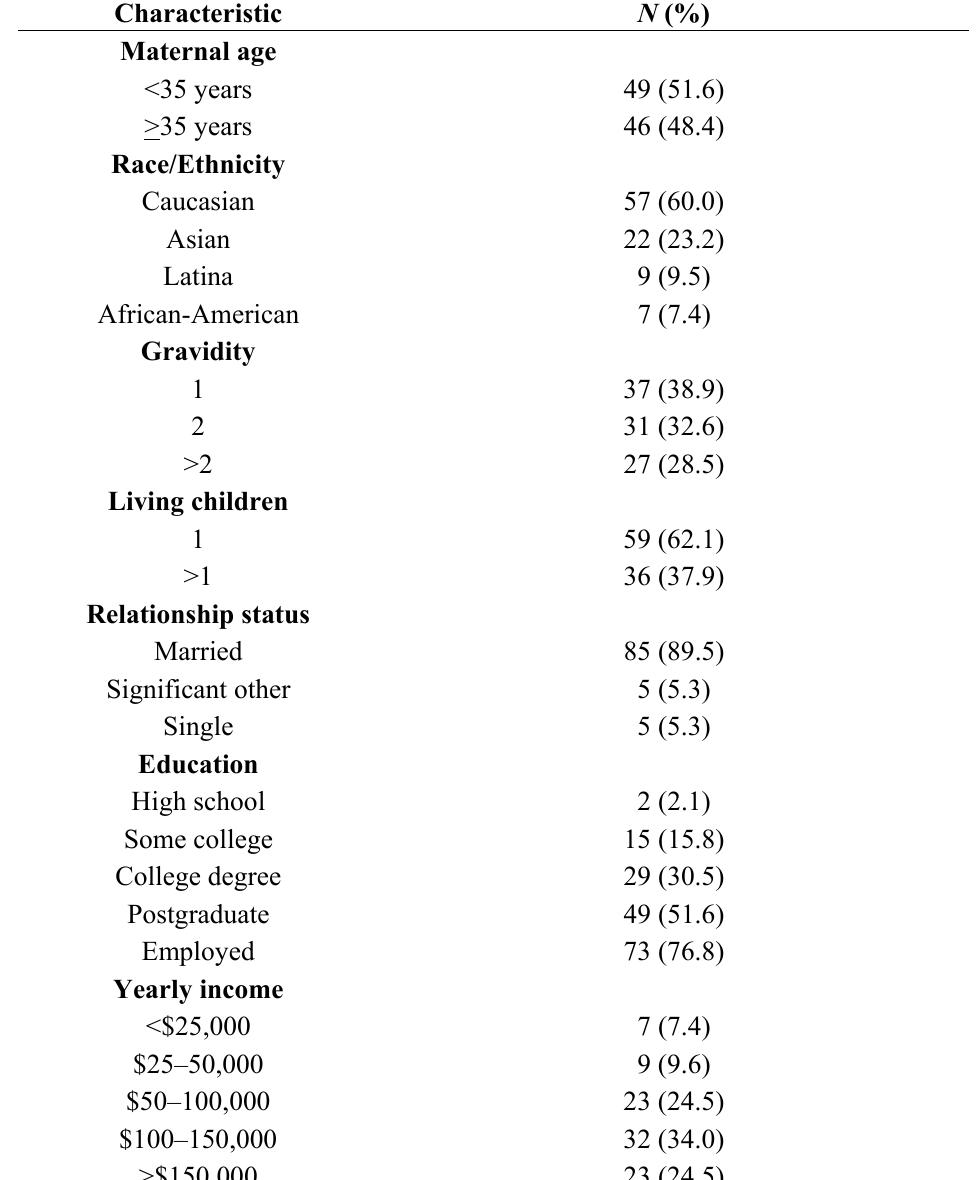
Table 2. Sociodemographic characteristics of the population.